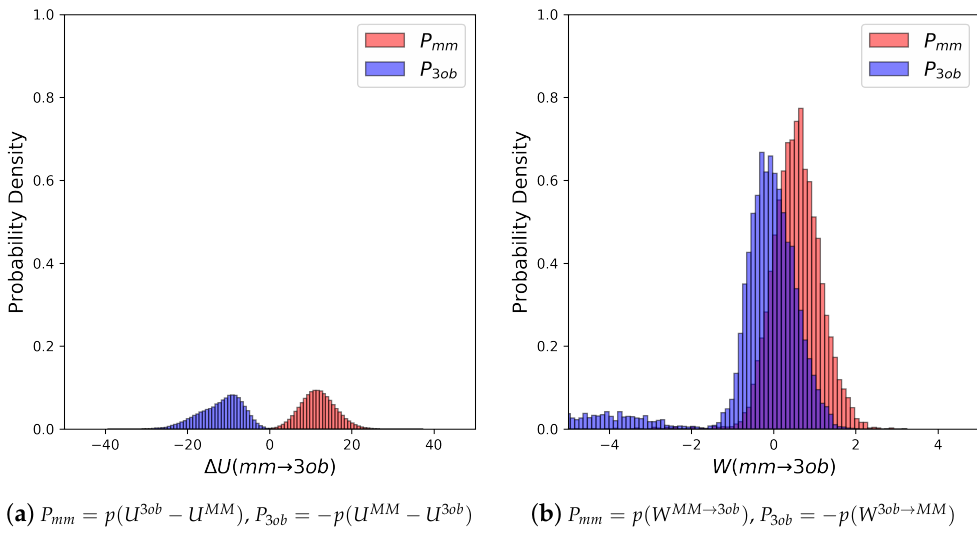
Figure 3. ( a ) Molecule 2 ’s potential energy “forward” ( P mm ) and “backward” ( P 3 ob ) distributions plotted as “offset” from the ∆ U MM → 3 ob to simplify the x-axis. ( b ) Molecule 2 ’s nonequilibrium work “forward” ( P mm ) and “backward” ( P 3 ob ) distributions plotted as “offset” from the W MM → 3 ob to simplify the